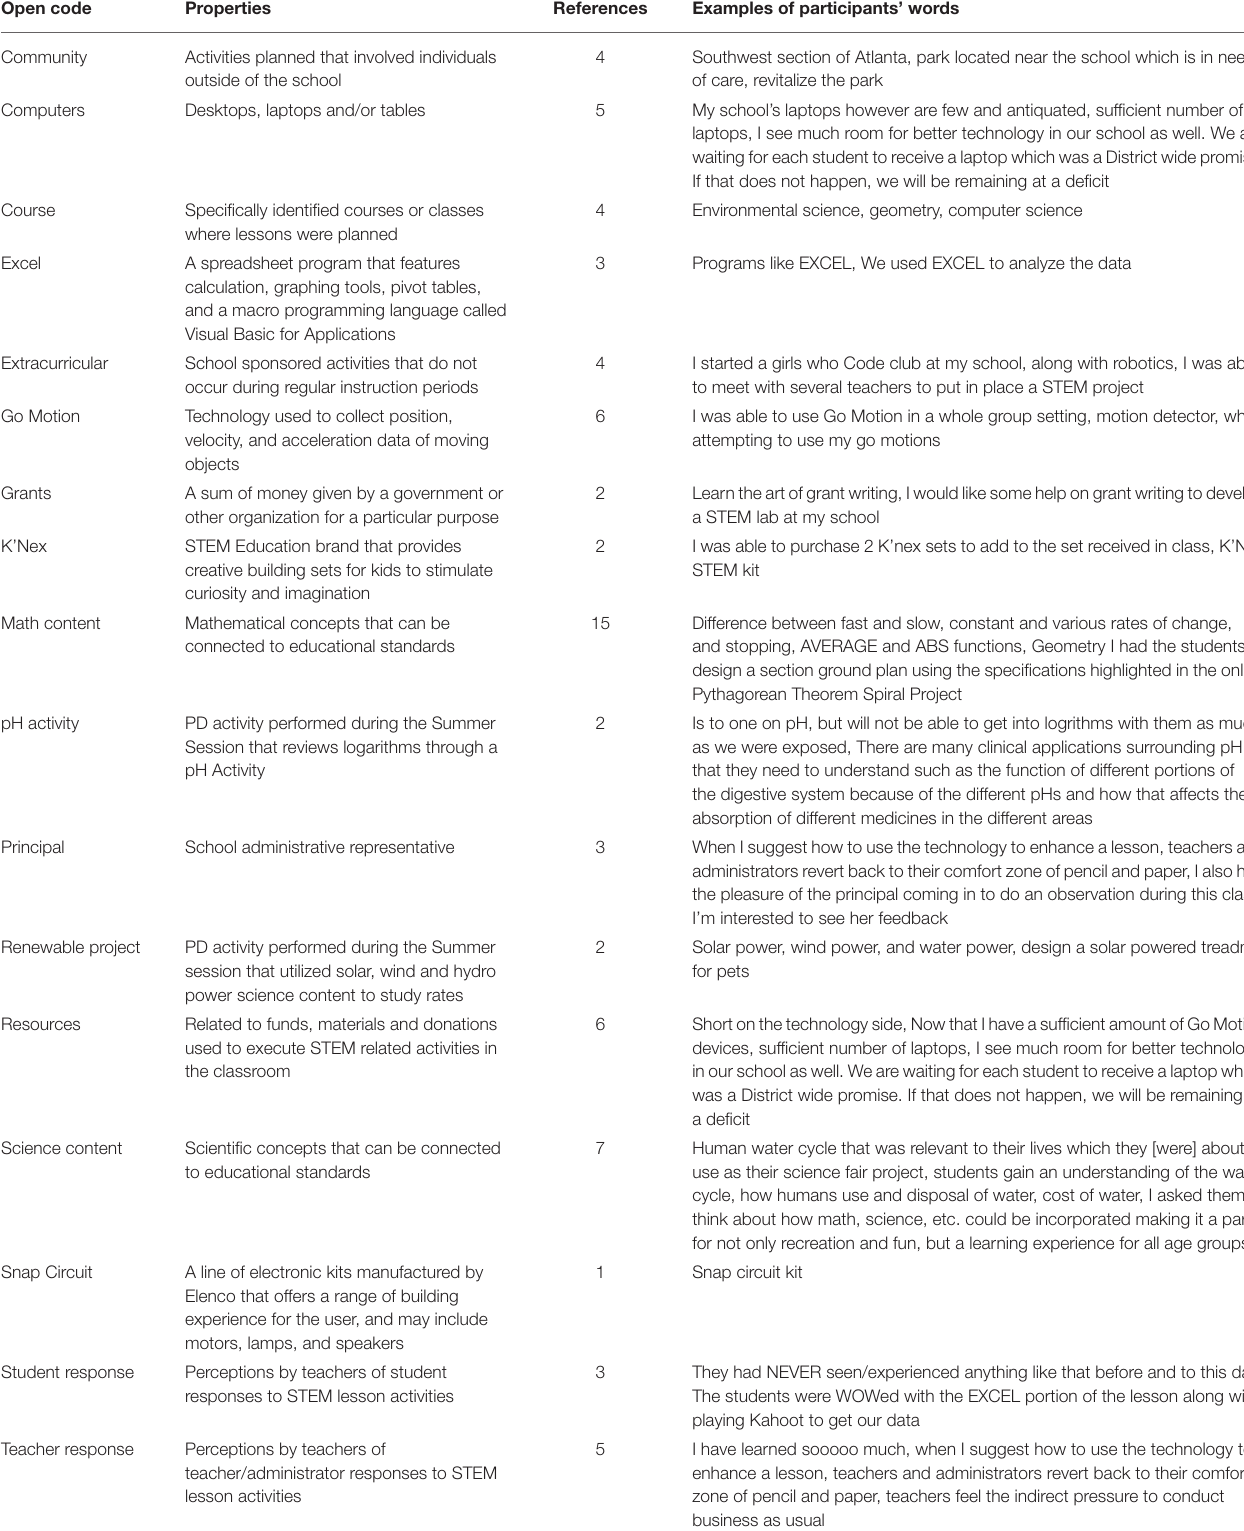
TABLE 2 | Overview of open codes in the qualitative